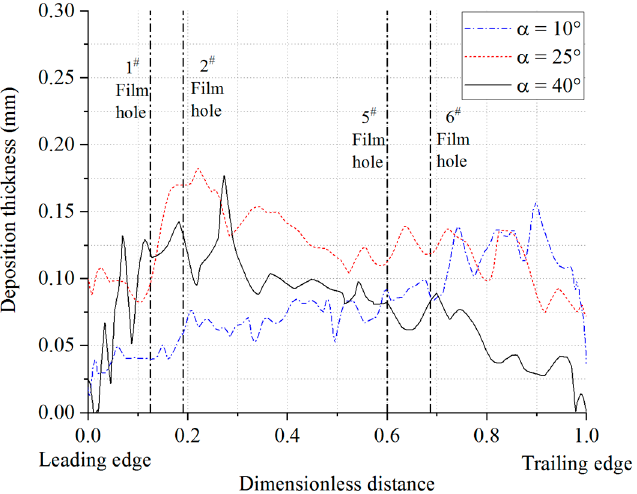
Figure 20. Surface deposition thickness plot for the pressure side of the test model angled at 10 ◦ , 25 ◦ and 40 ◦ (cross-section at midspan).